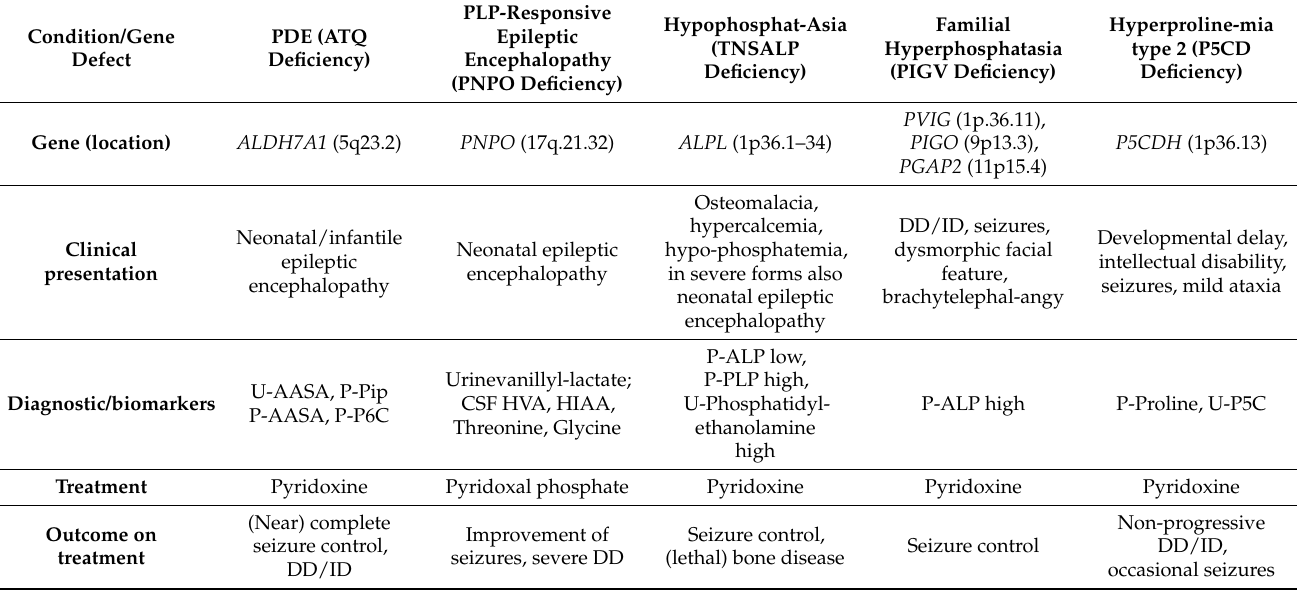
Table 2. Conditions causing vitamin B6-dependent/responsive epilepsies